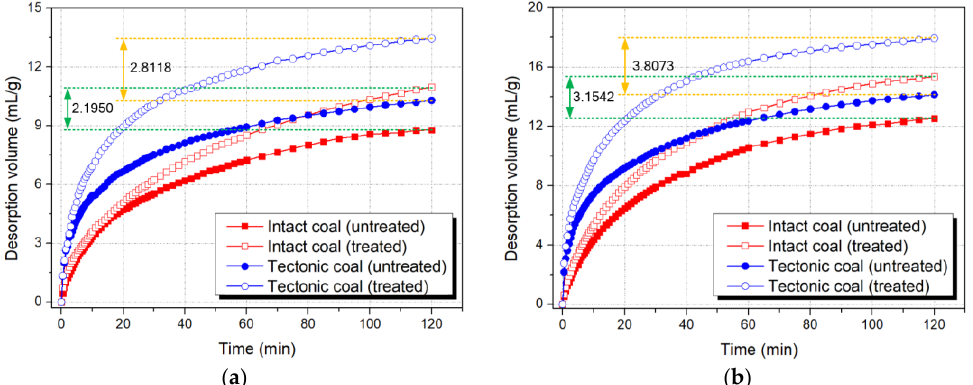
Figure 8. Methane desorption curves for untreated and ScCO 2 -treated coal samples: ( a ) 2 MPa; ( b ) 4 MPa. ( b ) 4